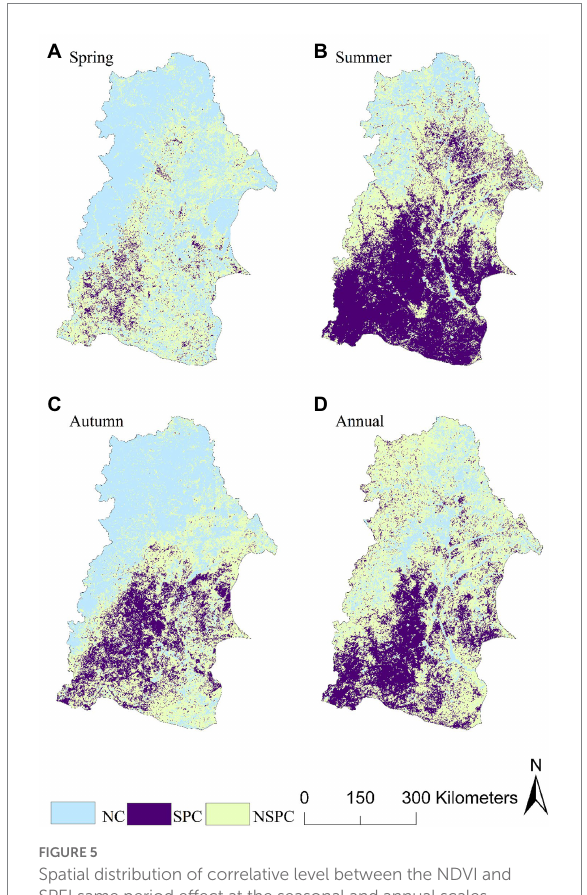
FIGURE 5 Spatial distribution of correlative level between the NDVI and SPEI same period effect at the seasonal and annual scales.